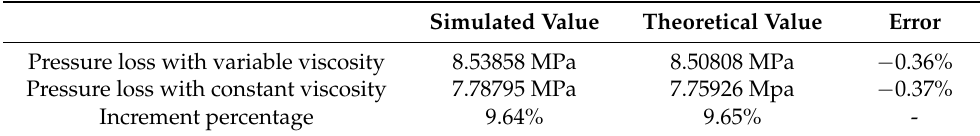
Figure 9. Velocity distributions at different positions. Table 2. Pressure